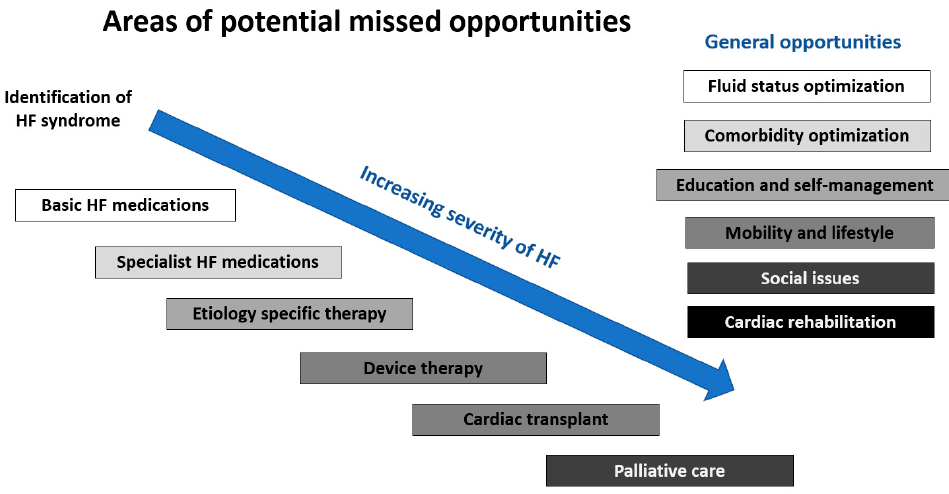
Figure 4. Missed opportunities in the treatment of patients with heart failure.